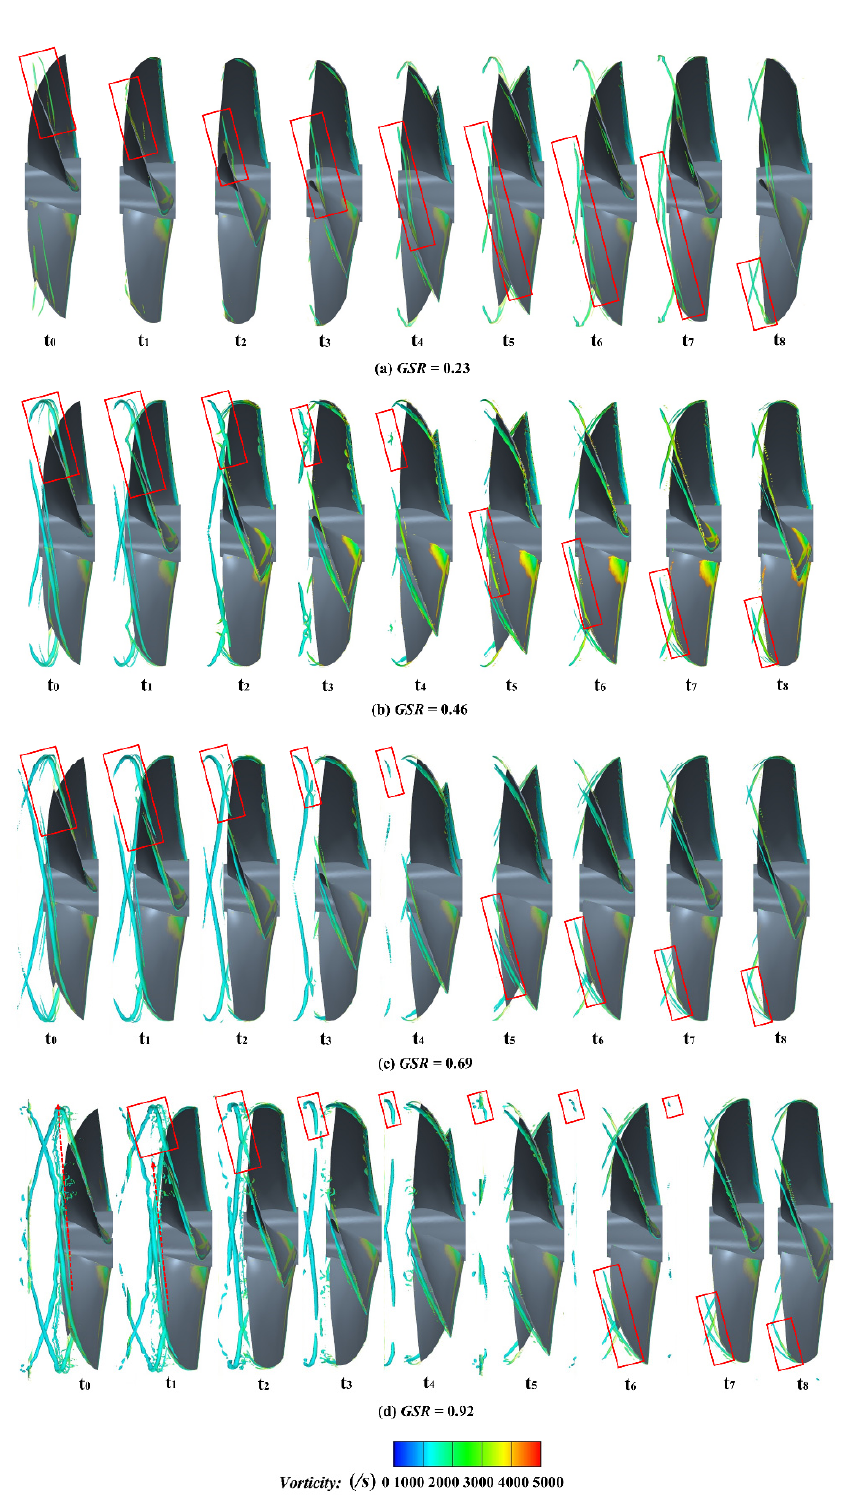
Figure 13. Generation and evolution process of tip leakage vortices (TLVs) of four ducted propellers. At GSR = 0.46 and 0.69, the vortex structures were relatively similar. Both essentially reached the maximum vortex development at time t 0 , and then began to attenuate and dissipate from t 2 to t 4 . Finally, the vortex structures had mostly dissipated at time t 5 , and a new vortex appeared. When the GSR was large—namely, GSR = 0.92 in this simulation—the flow phenomenon was different from the other cases. At t 0 , the red arrow indicates that the STLV of the previous blade extended into the vortex system of the next blade and